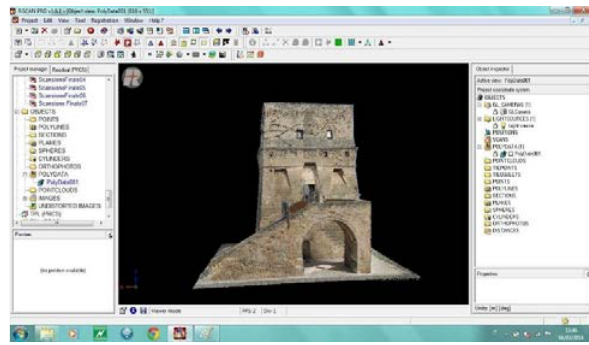
Figure 5: 3D Final textured